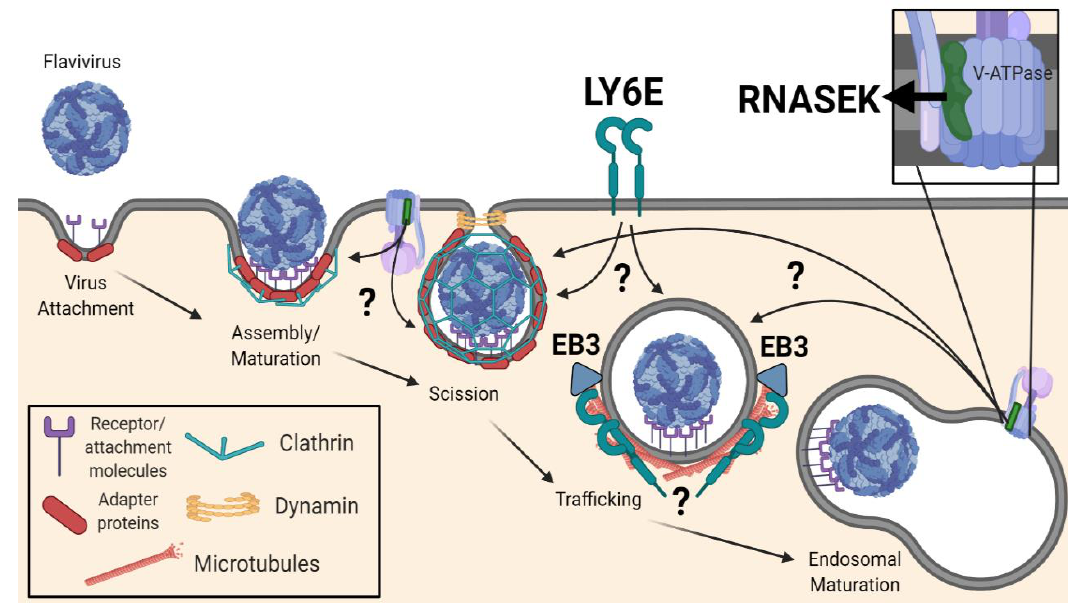
Figure 2. Schematic of the proposed size-dependent clathrin-mediated endocytic (CME) pathway. Following initial binding of an incoming flavivirus virion to the cell membrane, virions can bind attachment factors and receptors. Next, internalization begins and a clathrin coat forms around the membrane invagination via adapter molecules. Scission of the clathrin-coated vesicle is mediated by the GTPase dynamin. The internalized virion then traffics to the endosomal compartment for acid-mediated membrane fusion. During the internalization process, the GPI-anchored LY6E and V-ATPase-associated RNASEK perform essential roles outside of the canonical CME pathway. LY6E tubularization is induced by viral entry, a process dependent on microtubule function, the end-binding protein EB3, and RNASEK. Figure created with BioRender.com.